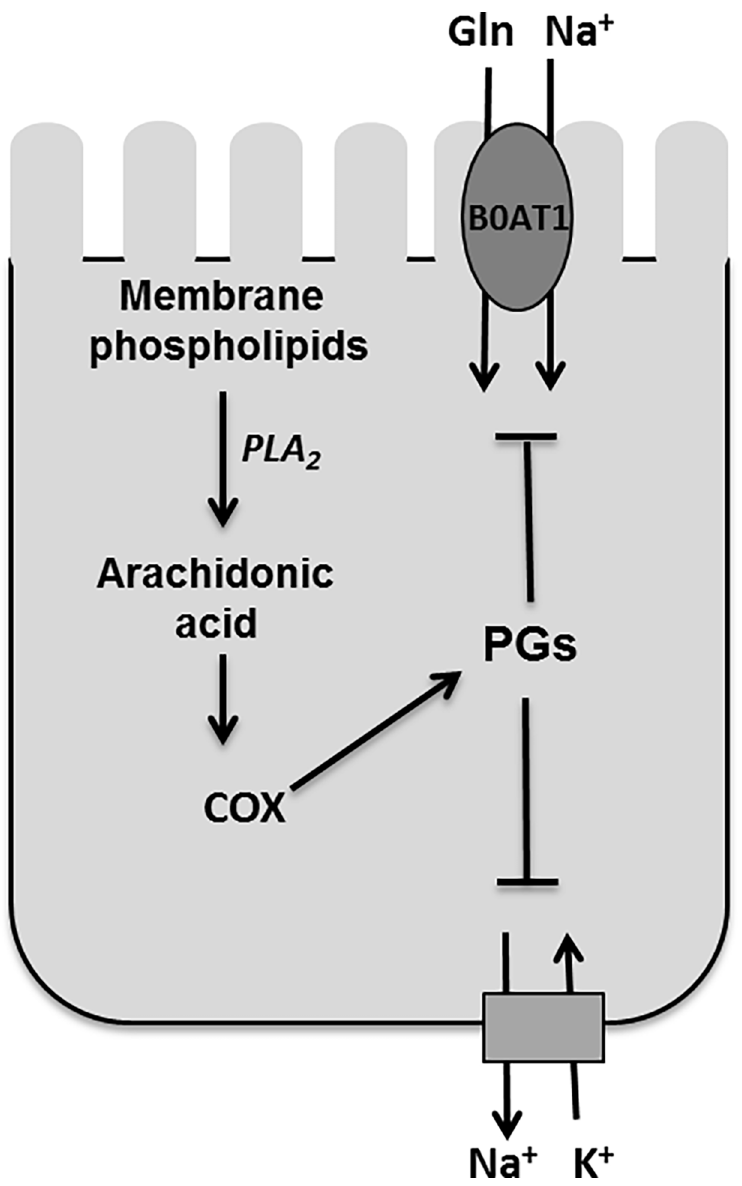
Fig 8. Cyclooxygenase pathway mediated inhibition of Na-glutamine co-transporter B0AT1 in rabbit villus cells during chronic intestinal inflammation. Na-glutamine co-transporter B0AT1 is regulated through arachidonic acid pathway, specifically COX pathway, in mammalian villus cells during chronic intestinal